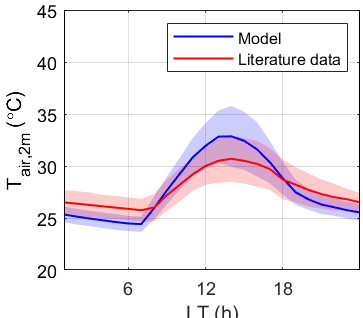
Figure 8. Comparison of modelled and measured mean diurnal cy- cle of 2m air temperature ( T air,2m ) in Singapore. Solid lines show hourly mean values and shaded areas ± 1 standard